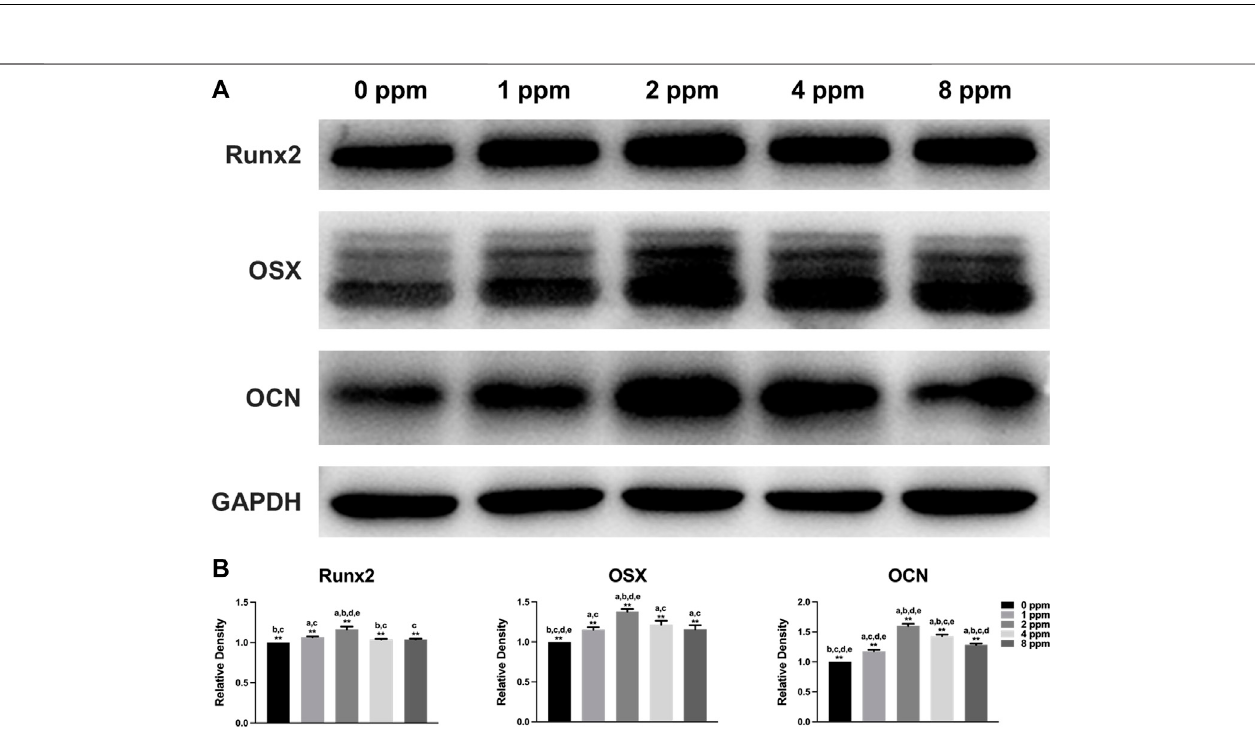
FIGURE 10 | Protein expression levels of osteogenic markers Runx2, OSX, and OCN of osteoblast-like MC3T3-E1 cells in different concentrations of CM (Runx2, Runt-related transcription factor 2; OSX, osterix; OCN,osteocalcin). Quanti fi cation wasperformed byImageJ software.Resultsare presented as mean ±SD (* p < 0.05, ** p < 0.01; N =